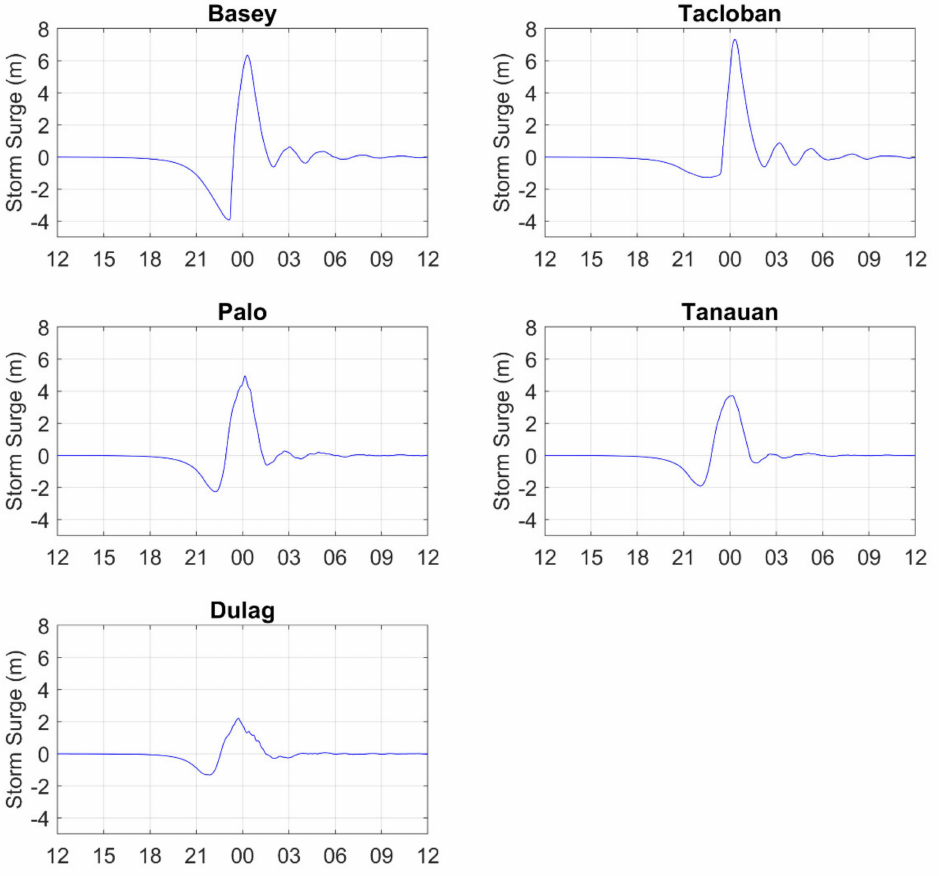
Figure 14. Time series of computed storm surges at specified numerical gauges: Basey, Tacloban, Palo, Tanauan, and Dulag. The y -axis indicates storm surge height in m, and the x -axis shows the time from 12:00 UTC on 7 November 2013 to 12:00 UTC on 8 November 2013. The locations of these numerical gauges can be found in Table